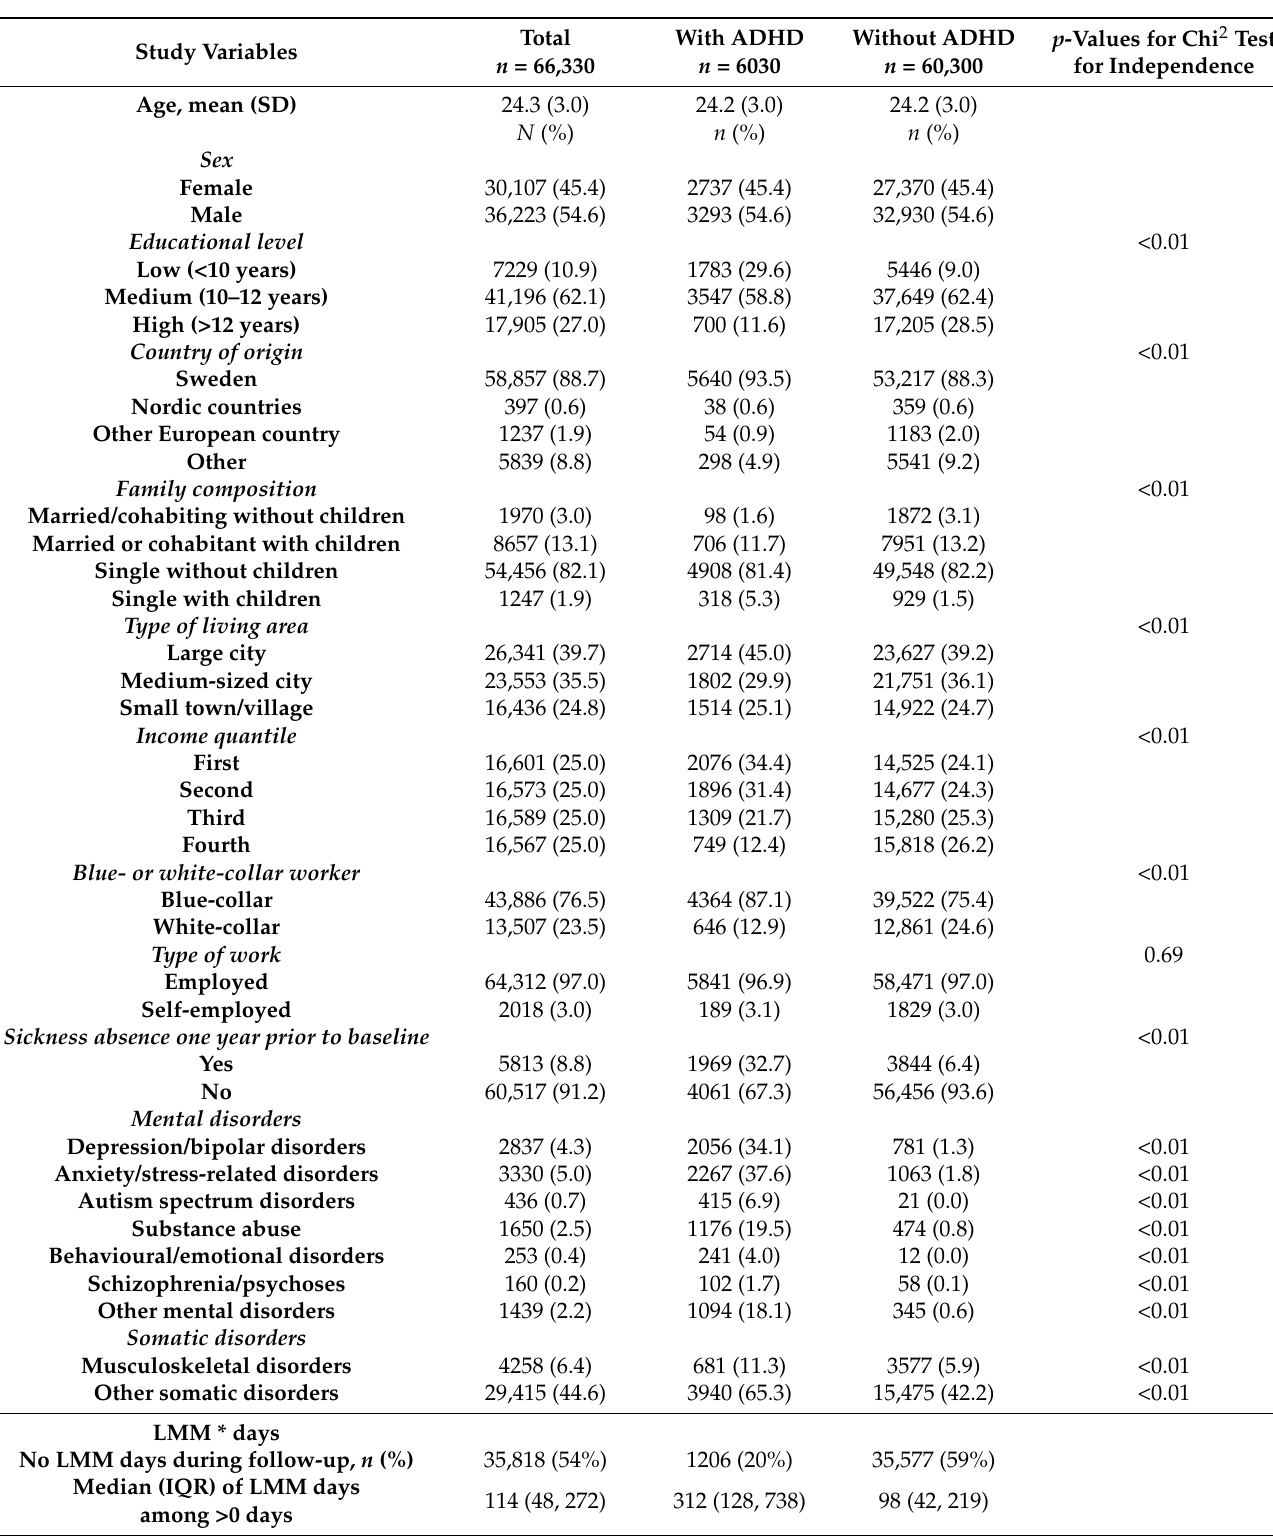
Table 1. Distribution of study variables by attention deficit hyperactivity disorder (ADHD) diagnosis among young employed